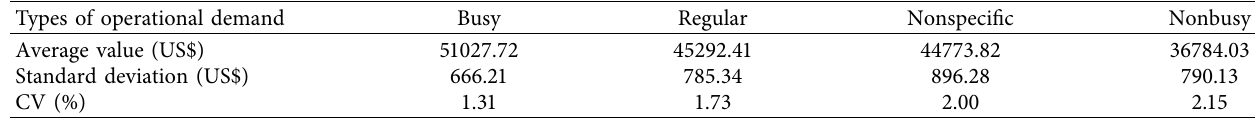
Figure 11: Objective values. Table 6: Numerical descriptive measures for objective values.